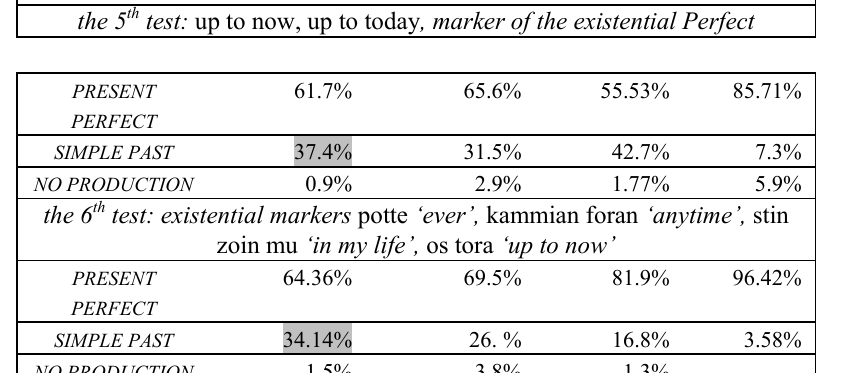
Table 1: Performance of all the pupils in each one of the